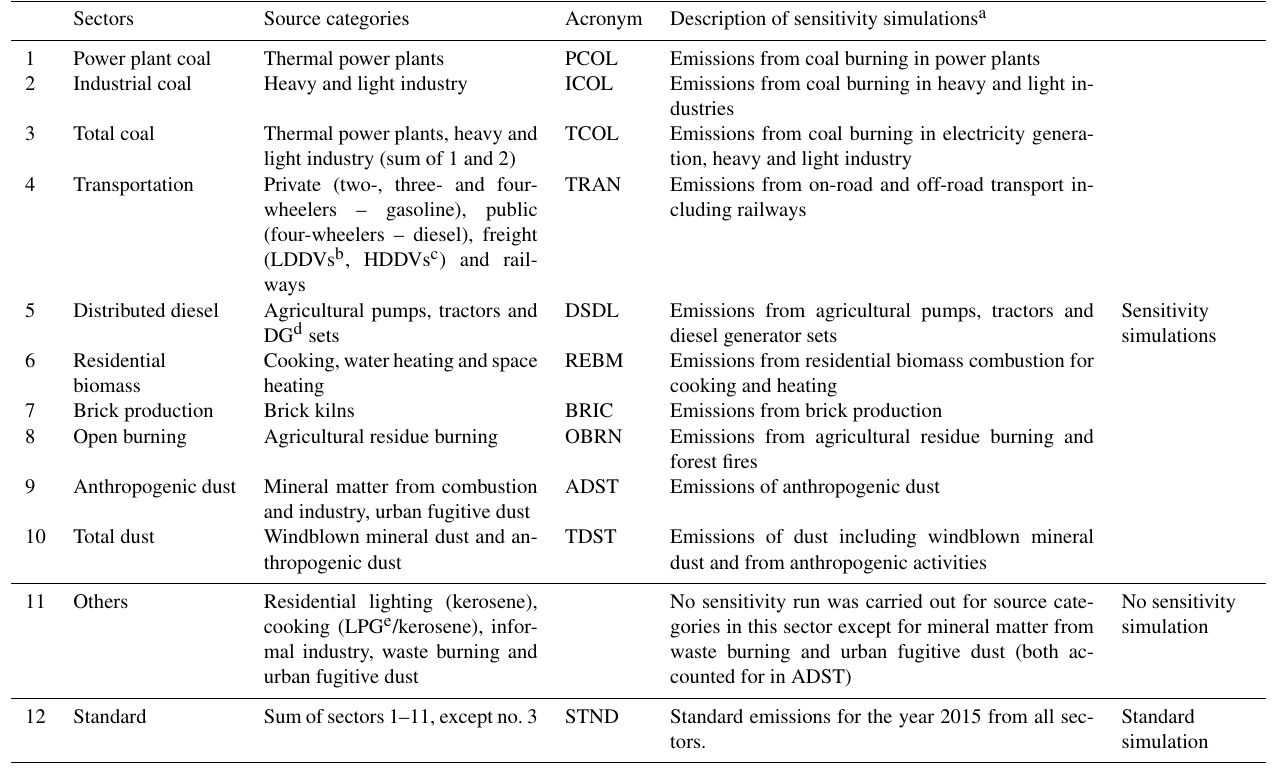
Table 1. Description of source categories and sensitivity